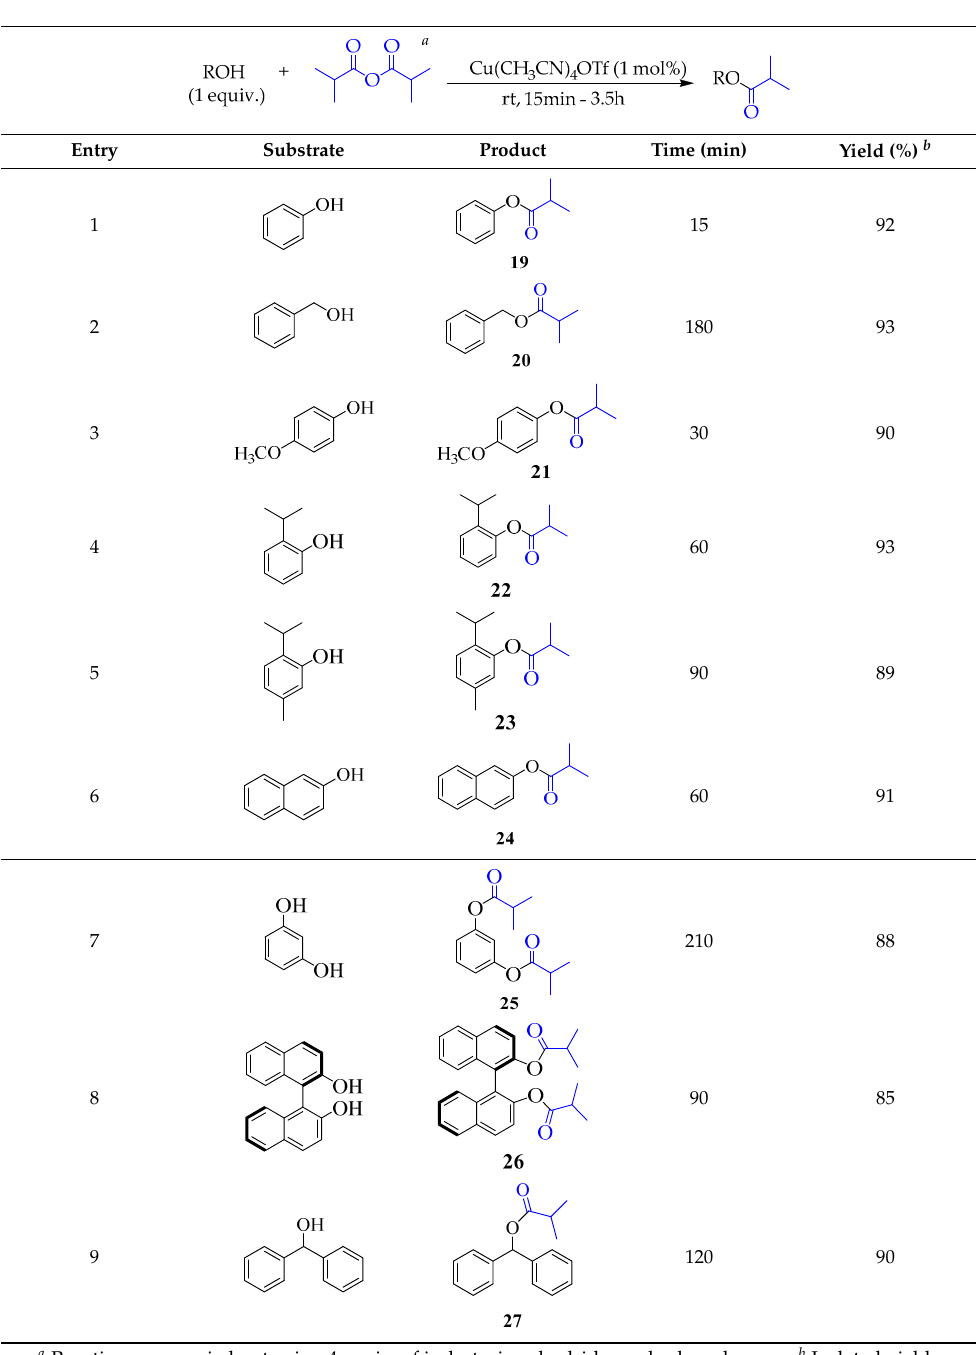
Table 2. Acylation of alcohols with isobutyric anhydride catalyzed by Cu(CH 3 CN) 4 OTf.